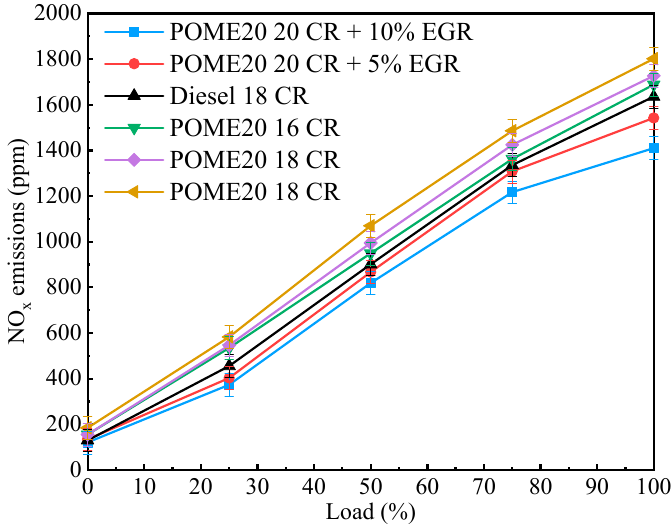
Figure 27. NO x emissions comparison of POME biodiesel blends and diesel under different loads [241].